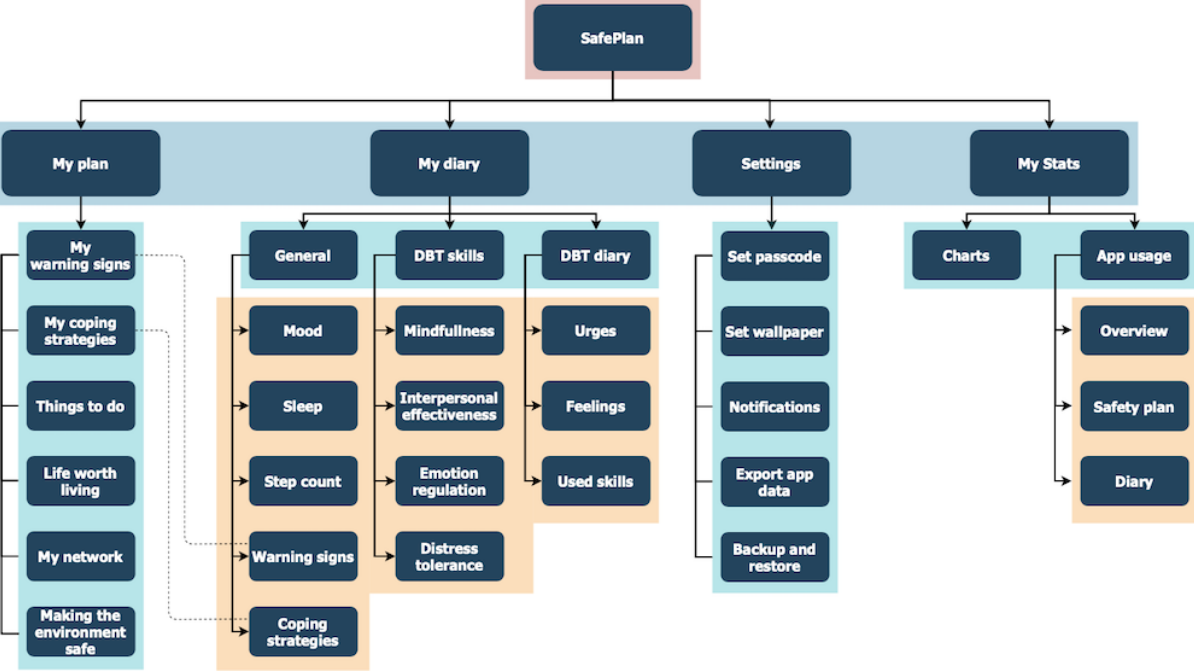
Figure 3. Functional design of SafePlan use